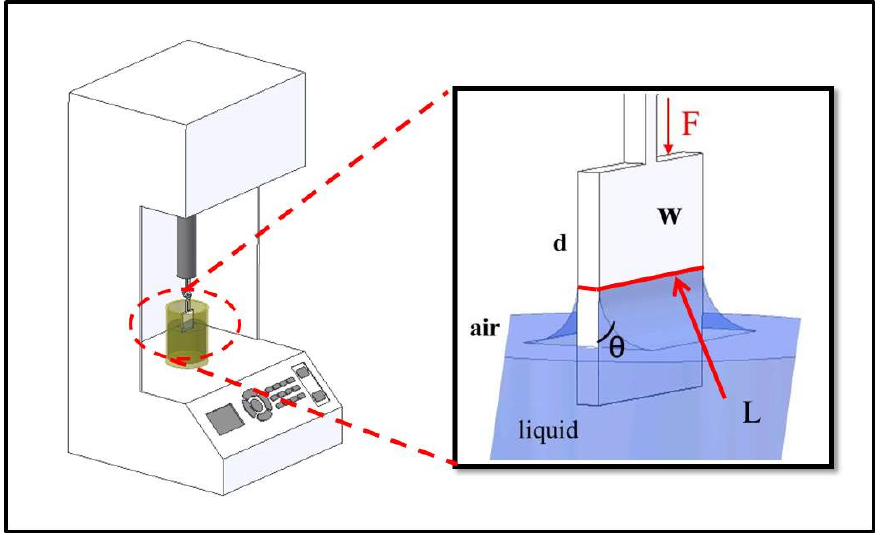
Figure 2. Surface tension measurement.